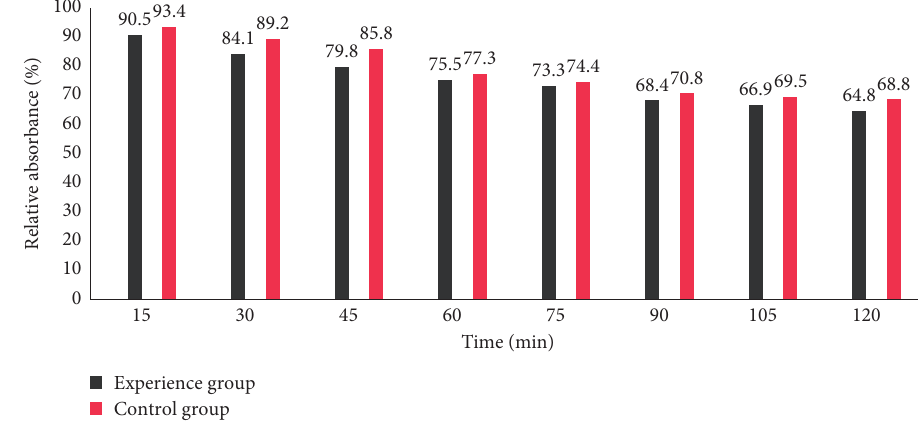
Figure 4: In vitro dynamic coagulation test results of the two groups. Table 1: Red blood cell hemolysis rate of different